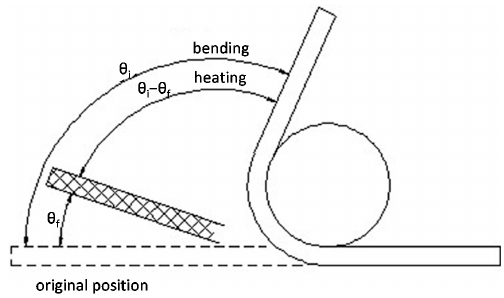
Figure 1. Shape memory model.